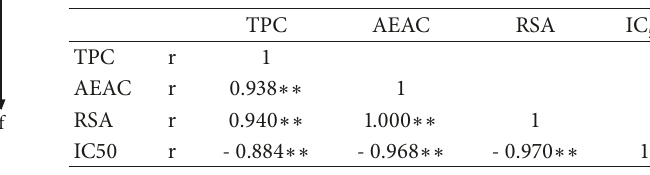
Table 4: Correlations between total phenolic contents and RSA of honey